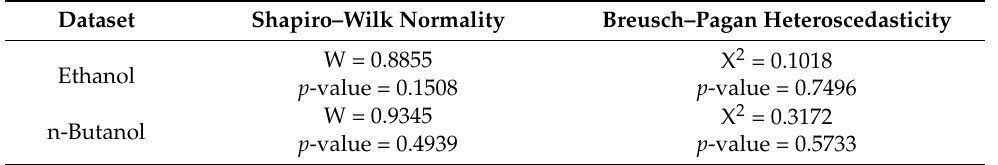
Table 6. Assumptions tests.